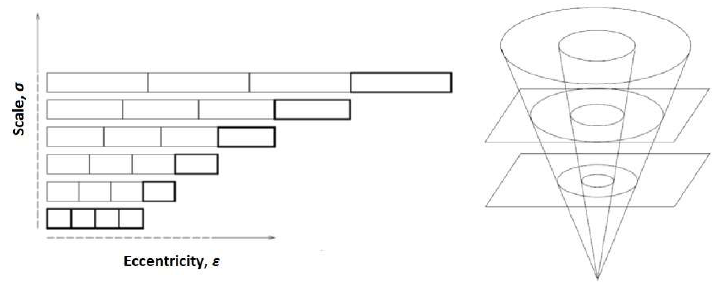
Figure 10. Illustration of varying spatial support across scales in foveal scale space [41].